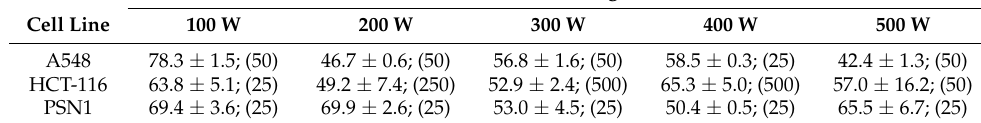
Table 2. Cell viability of human tumoral cells contacted with the liquid phases obtained after ultrasound-assisted extraction (UAE) from 20 to 120 min. The A549 and TG98 cell lines did not show cell inhibition. Data represent the mean ± SEM ( n = 3). Cell Viability (%) Obtained at Different Extraction Times (Extract Concentration in µ g/mL) Cell